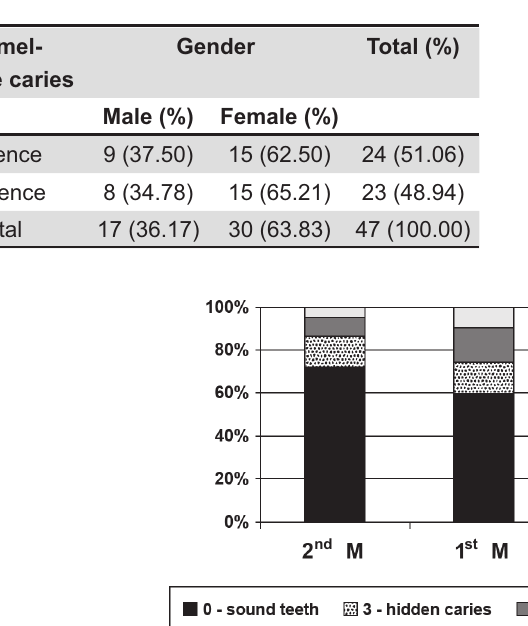
Table 2- Distribution of patients by gender with and without enamel-dentin caries (p=0.9672)